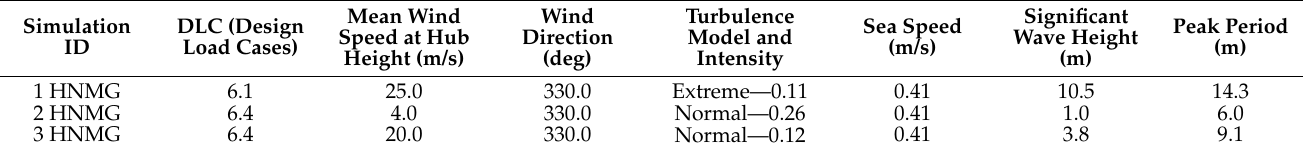
Table 1. Different load cases selected to compute the